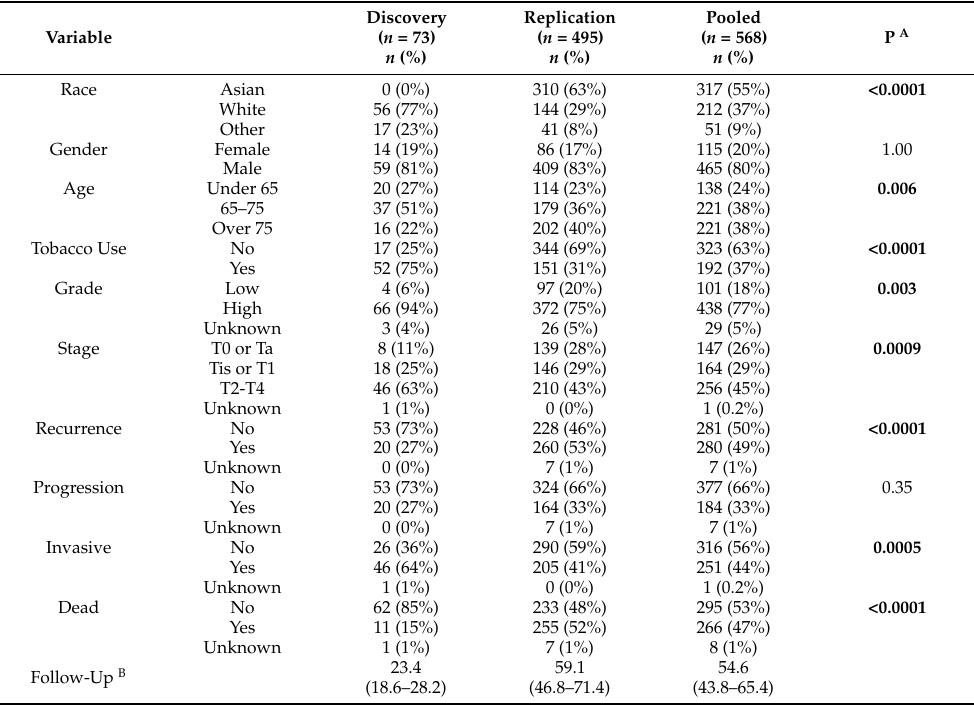
Table 1. Demographic characteristics among patients with bladder